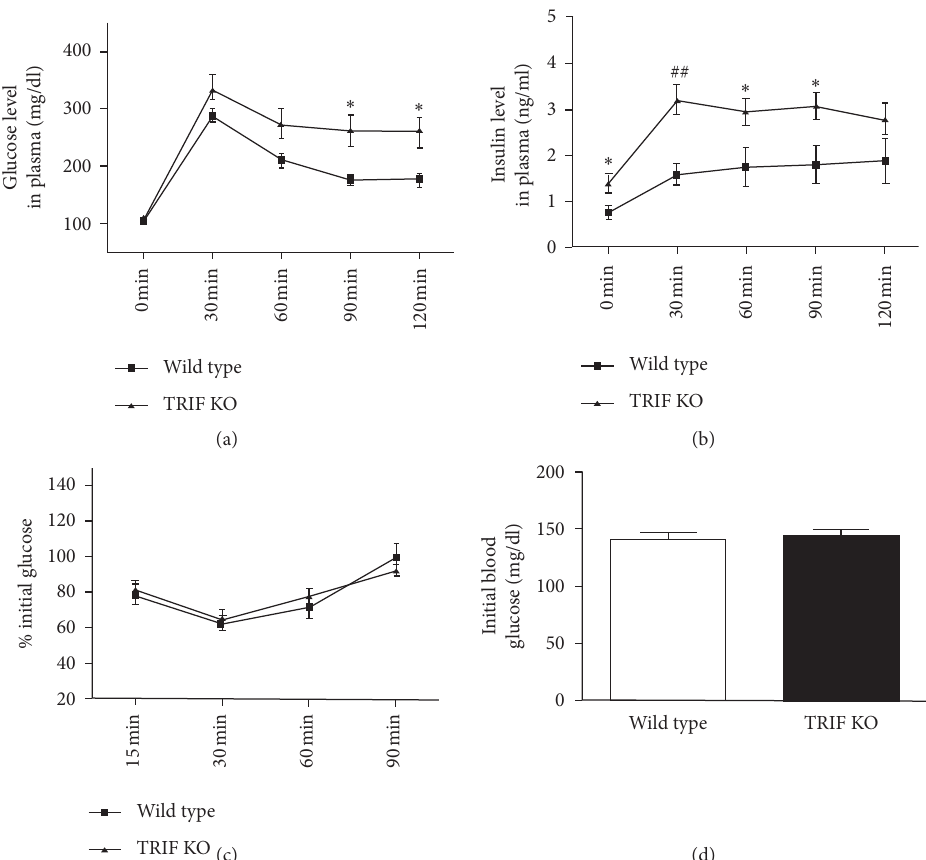
Figure 2: Effects of TRIF deficiency on the IPGTTand ITT. (a) At the age of 46 weeks, mice were fasted for 16 h and injected i.p. with 1.5g glucose/kg bodyweight, and (b) blood glucose and insulin were measured before and after glucose injection at the indicated time points. (c) At the age of 47 weeks, mice were fasted for 4h and injected i.p. with 0.75 U insulin/kg bodyweight for the ITT. Blood glucose levels were determined and are shown as percent changes from (d) basal blood glucose levels ( ∗ P < 0 . 05, ## P < 0 . 001) ( n �